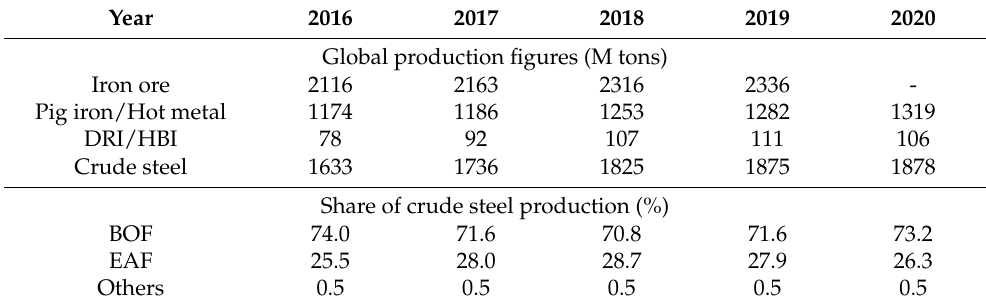
Table 1. Annual global iron ore, pig iron and steel production figures for 2016 to 2020 [4,11,12].